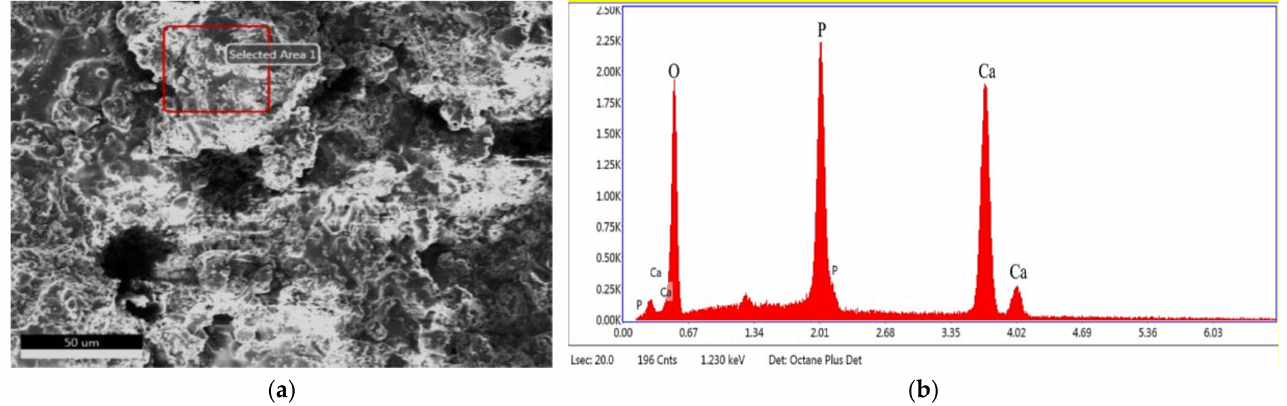
Figure 8. Element distribution of the HA coating surface: ( a ) EDS scanning region, ( b ) corresponding element